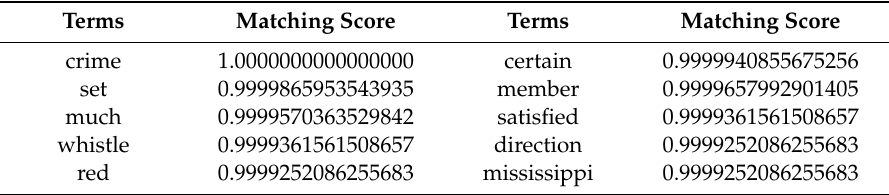
Table A9. Top terms for term